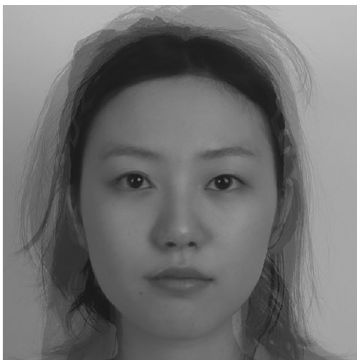
Figure 5. A sample of the face images used in Experiment 2. To protect model privacy, we show an average face created from a few of the face images